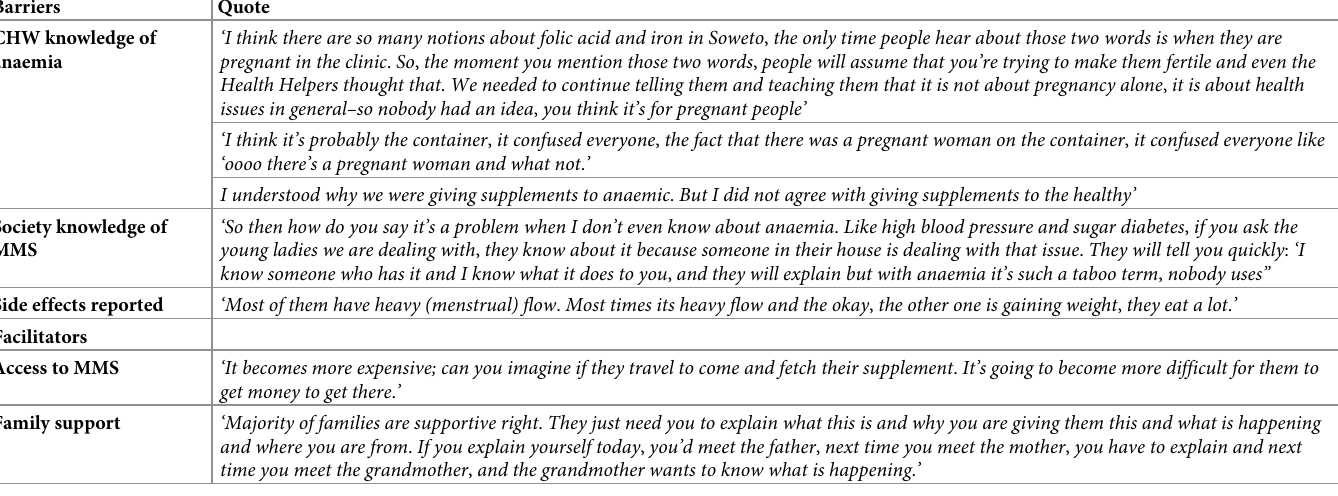
Table 2. CHWs quotes regarding barriers and facilitators to supplementation